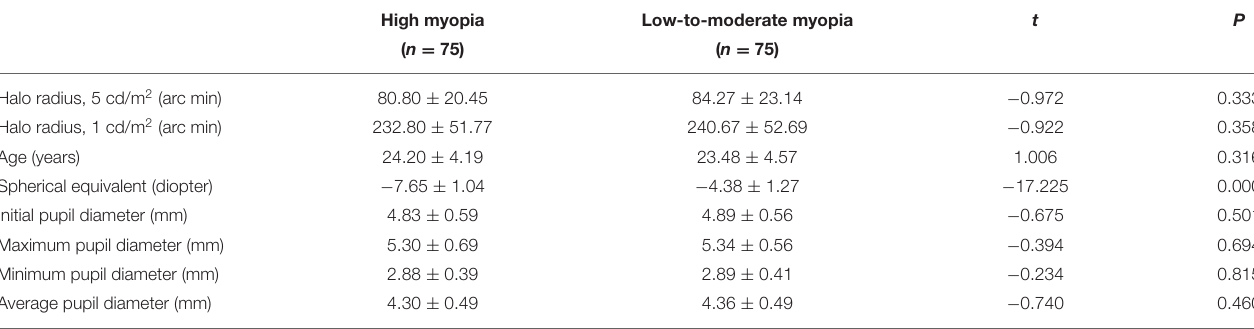
TABLE 3 | Halo radius and dynamic pupil values in different myopic groups.